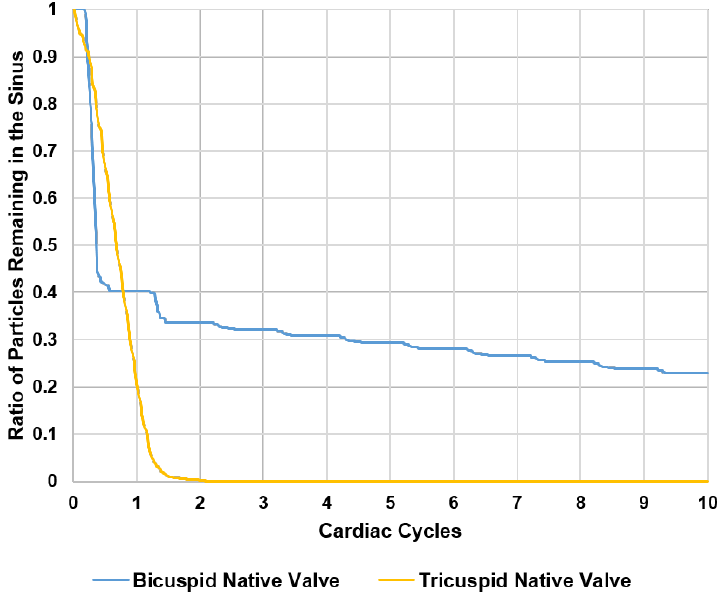
Figure 4. Survival probability curve of particles remaining in the bicuspid valve sinus and the tricuspid valve sinus. valve